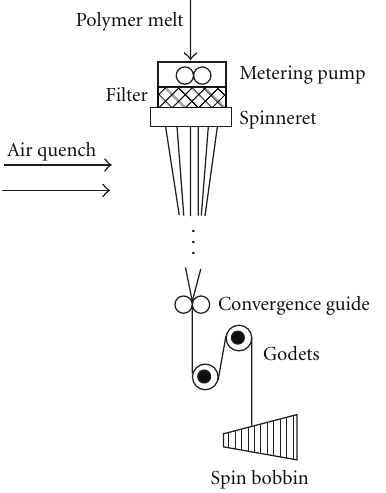
Figure 1: Fiber melt-spinning